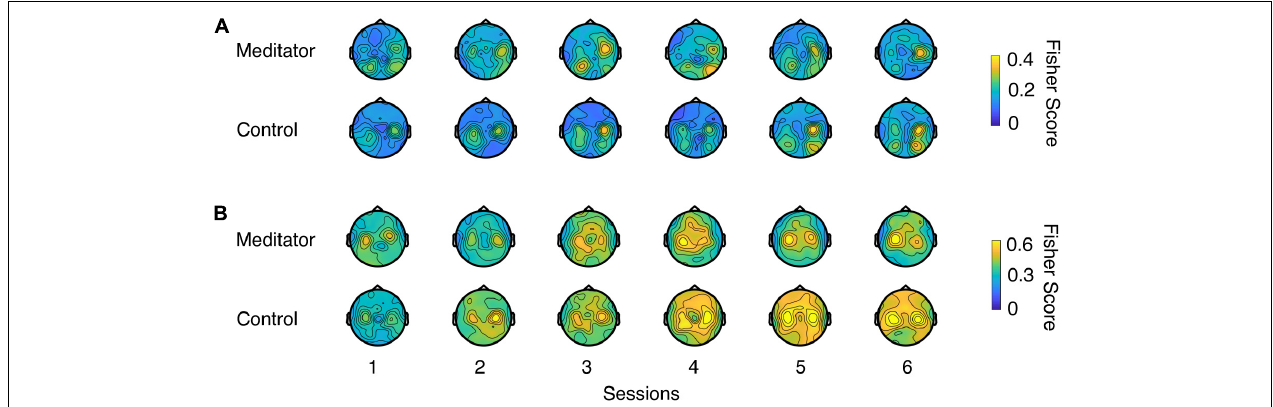
FIGURE 4 | Fisher score topology for meditators and controls during (A) LR and (B) UD task as session goes on. Fisher score describes the mu rhythm contrast between two opposite contexts in a task (e.g., left trials and right trials in LR task, or up trials and down trials in UD task).